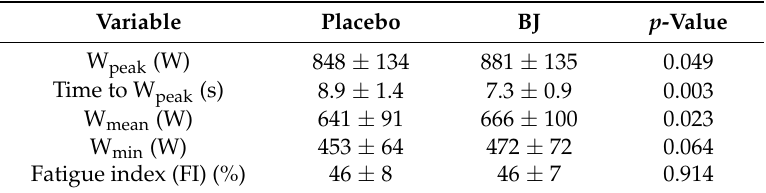
Table 1. Effects of placebo or BJ intake on performance at a 30-s sprint (Wingate)